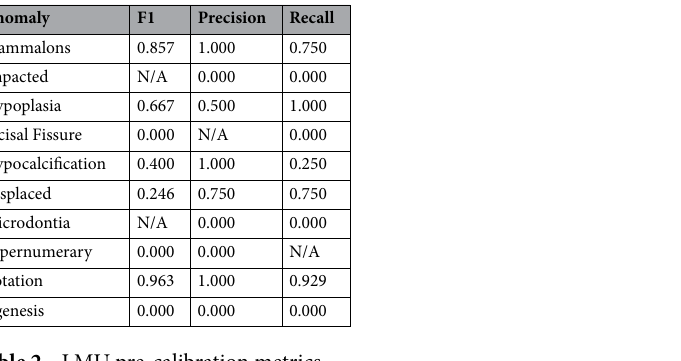
Table 2. LMU pre-calibration